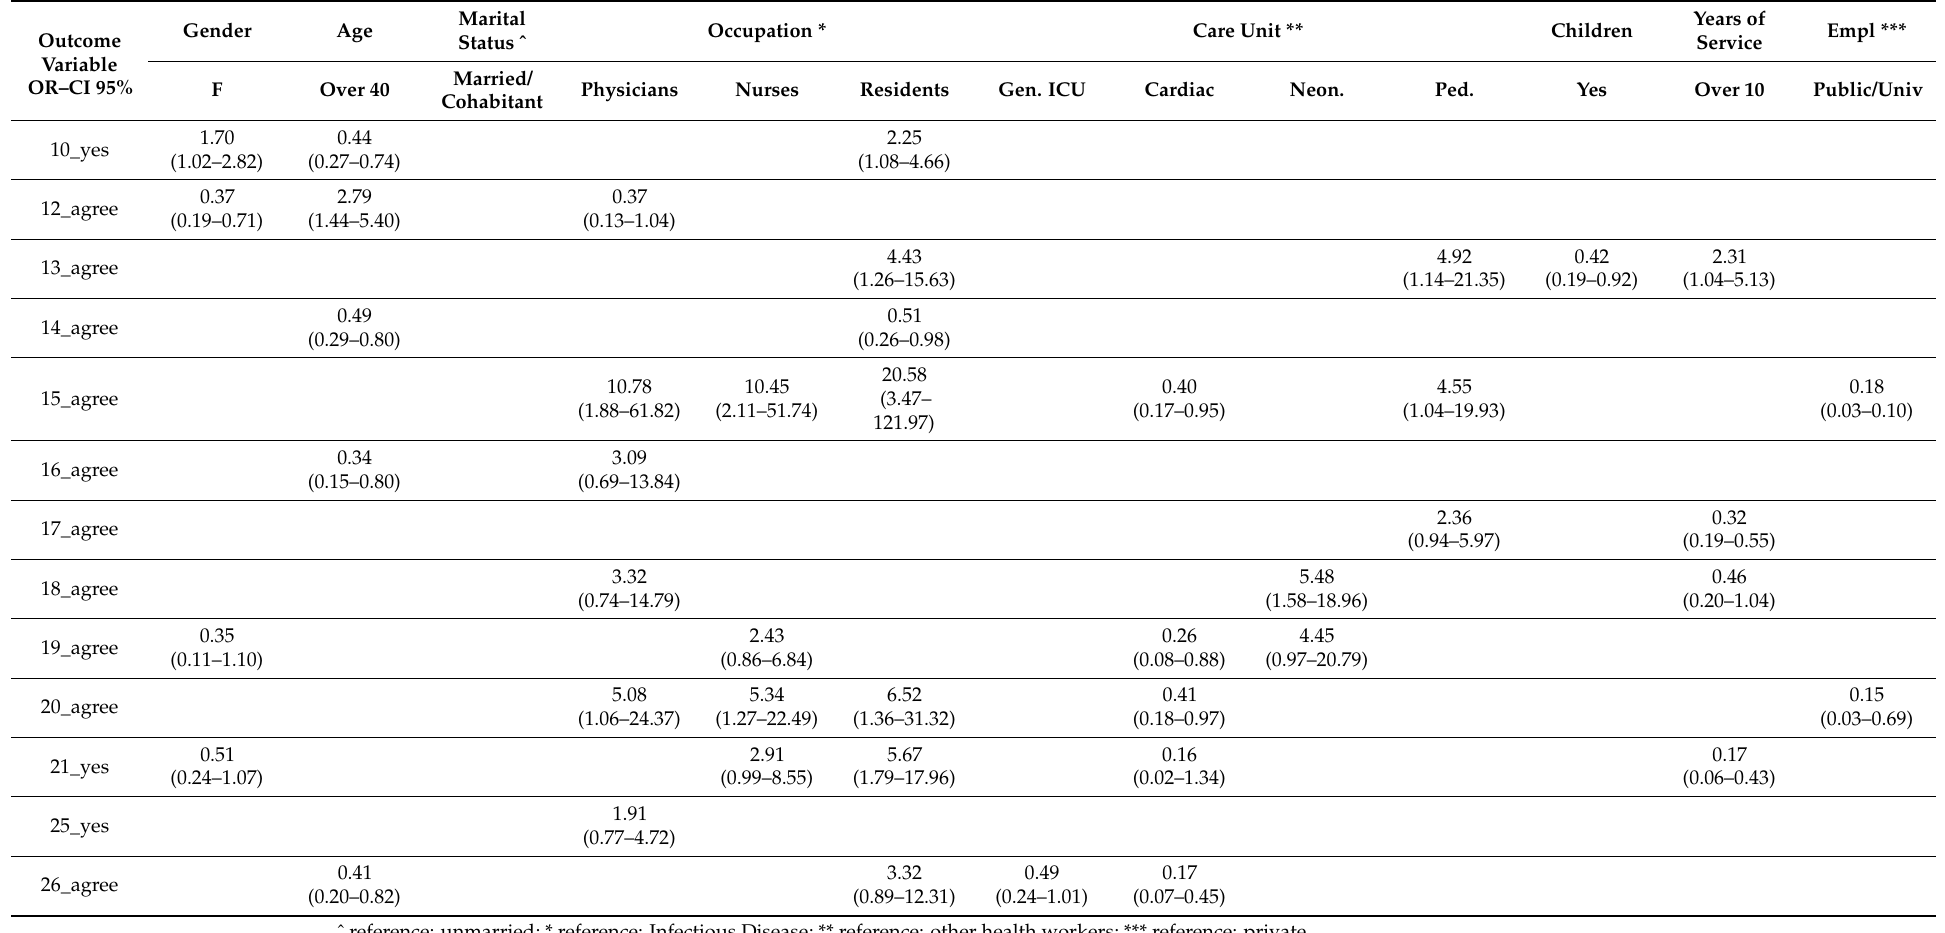
Table 5. Results of multivariate analysis—OR (95%CI) positive